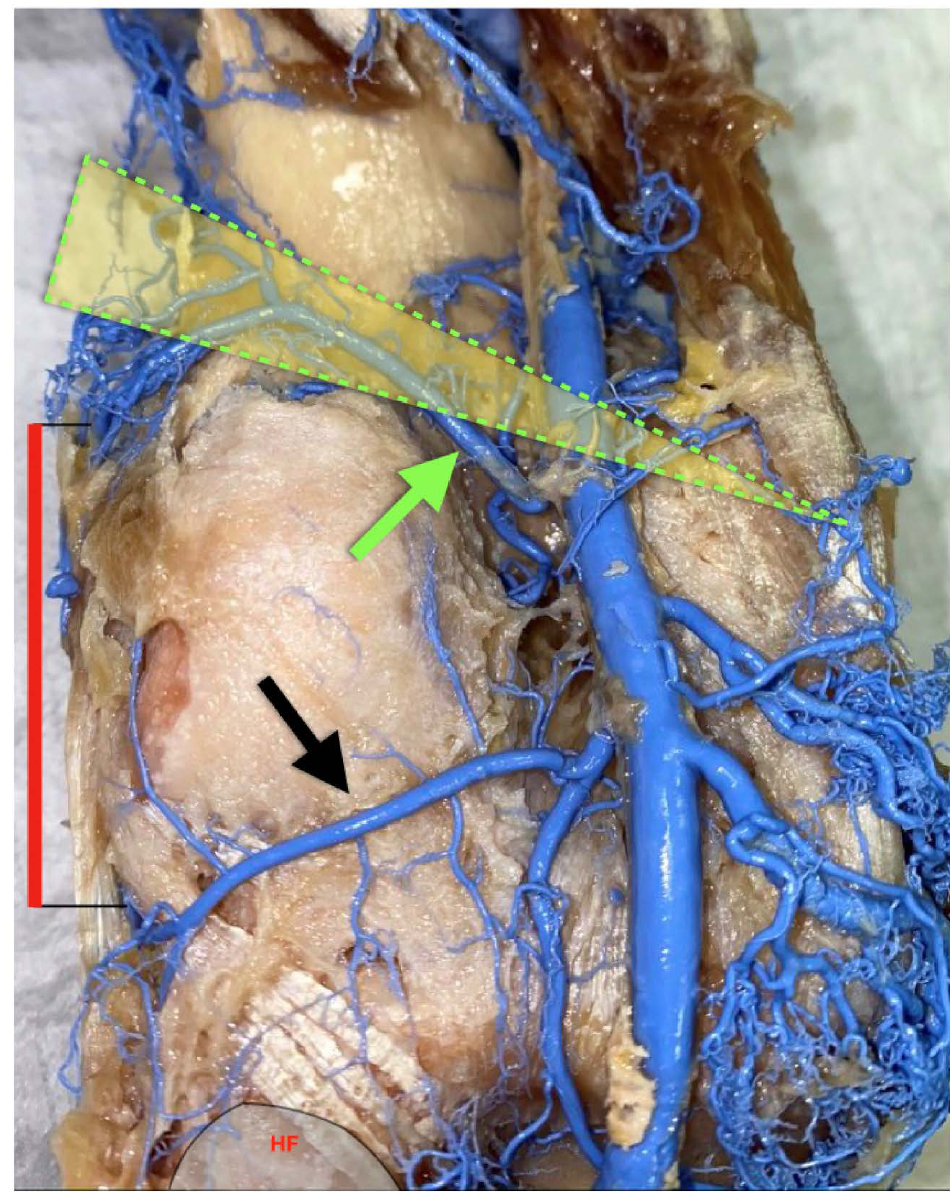
Figure 4. Left knee, posterior view. Mean distance of superior lateral genicular artery (green arrow) from joint line at the lateral knee (red line) was measured to be 52.2 mm ± 6.2 mm by Barner et al. [3]. Bissichia et al. [4] found that the superior lateral genicular artery was in a risk zone during opening- wedge distal femoral osteotomy (green triangle). The median distance from the osteotomy site approximated 3 mm. Black arrow: inferior lateral genicular artery; HF: head of